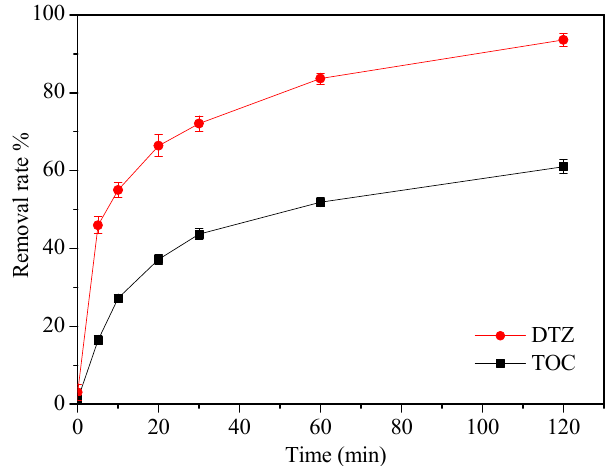
Figure 9. The removal rate of TOC (Total organic carbon) and DTZ. [DTZ] = 20 mg L − 1 ; [nZVI/2BC] = 0.45 g L − 1 ; [PS] = 25.0 mM; Temp = 25 °C; pH = 7.0.